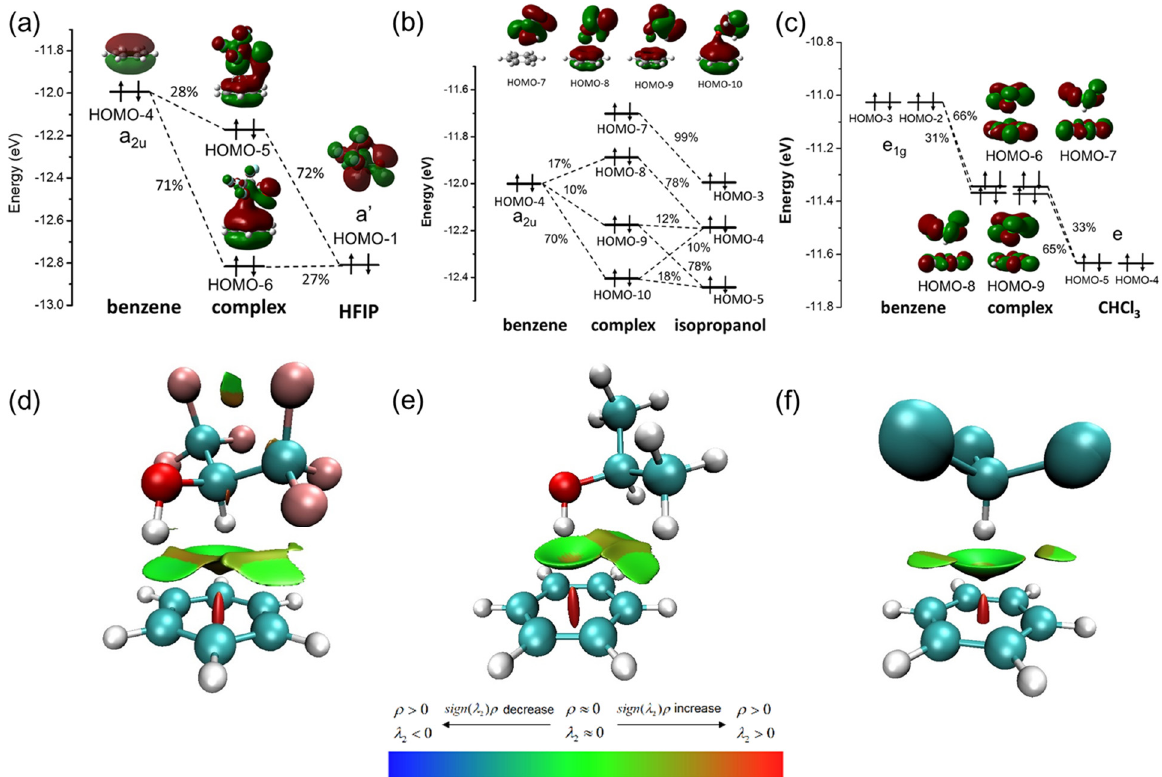
Figure 3. The CDA of ( a ) HFIP/PhH complex, ( b ) IP/PhH complex, and ( c ) CHCl 3 /PhH complex, and RDG isosurfaces of ( d ) HFIP/PhH complex, ( e ) IP/PhH complex, and ( f ) CHCl 3 /PhH complex.